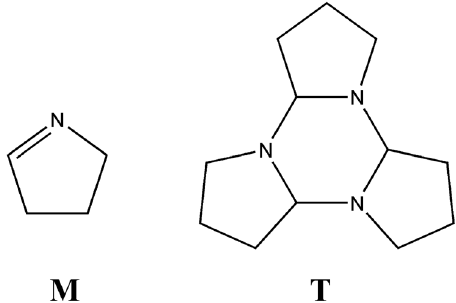
Figure 1. The monomer and the trimer states of 1-pyrroline.